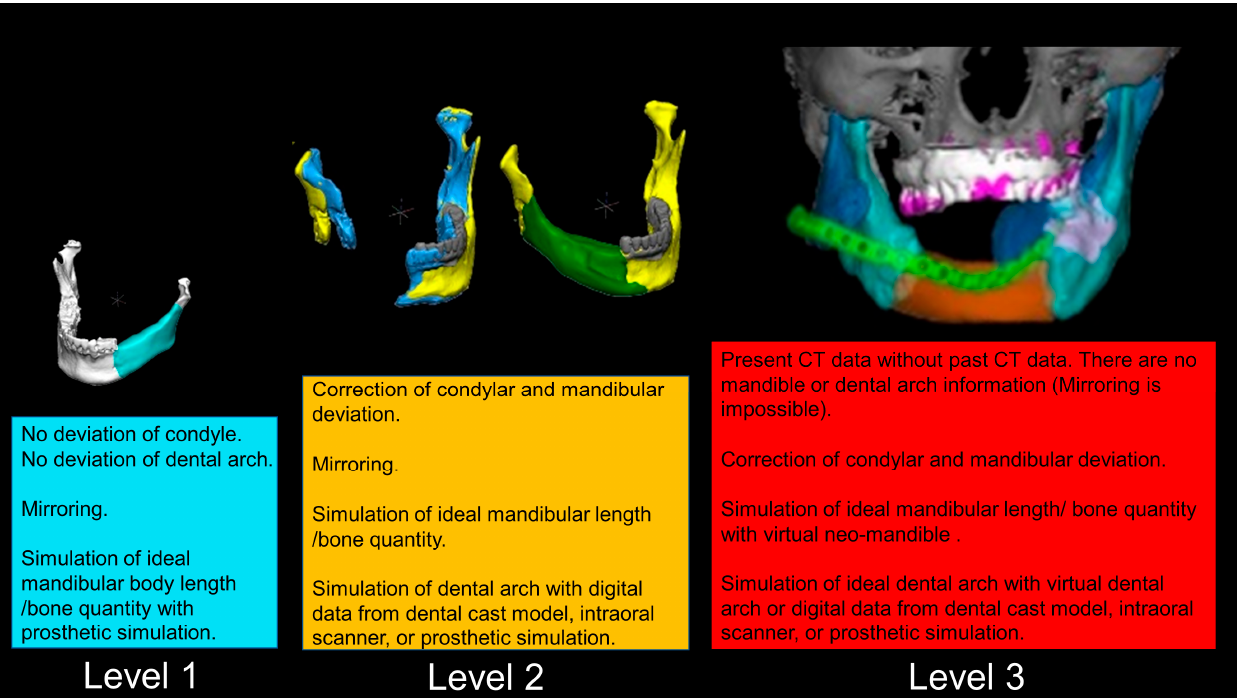
Figure 17. Schematic algorithm for the virtual reconstruction of the mandible with digital data. Level 1 is a relatively simple procedure. Level 2 includes deviation of the condyle and mandibular body. Level 3 is a complicated case that has lost information on original mandibular morphology with condylar and mandibular deviation.